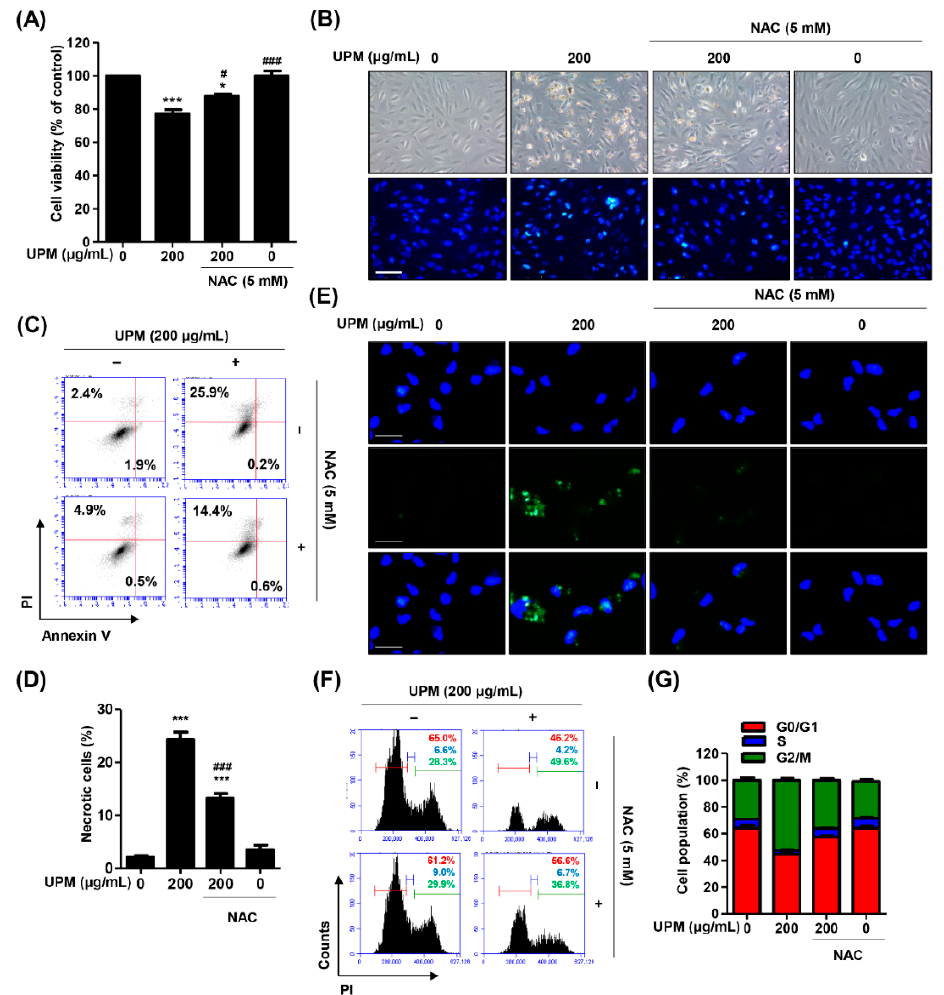
Figure 5. Suppression of ROS attenuates UPM-induced necrosis, auophagy, and cell cycle arrest in AREP-19 cells. The cells were pretreated with 5 mM NAC for 1 h and then treated with 200 μ g/mL UPM for 24 h. ( A ) Cell viability measured by a CCK-8 assay. Data are expressed as the mean ± SD (n = 4). * p < 0.05 and *** p < 0.001 when compared to untreated cells. # p < 0.05 and ### p < 0.001 compared to 200 μ g/mL UPM-treated cells. ( B ) The shape of the cell and the morphological changes in the nucleus. Scale bar: 75 μ m. ( C ) Representative histograms of cell death mode. ( F ) Cell cycle profiles derived from flow cytometry analysis. ( D ) The percentages of necrotic cells. Data are ex- pressed as the mean ± SD ( n = 5). *** p < 0.001 when compared to untreated cells. *** p < 0.001 com- pared to 200 μ g/mL UPM-treated cells. ( E ) Cyto-ID-stained cells (autophagic cells, green) and DAPI- 75 µ m. ( G ) The average percentages of cells in each phase of the cell stained cells (nuclei, blue) captured under fluorescence microscopy. Scale bar: 75 μ m. ( G ) The aver- age percentages of cells in each phase of the cell cycle.